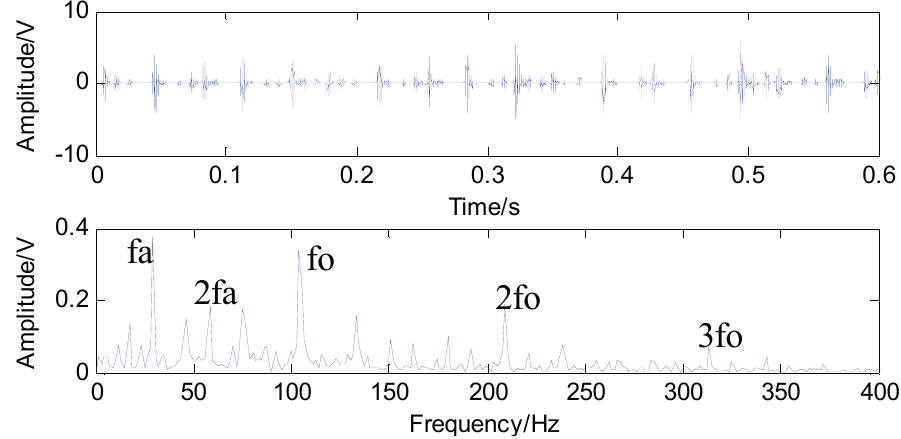
Figure 12. Time waveform of the filtered signal with an outer race defect using fast NL-Means ( a ); and the envelope spectrum of the filtered signal ( b